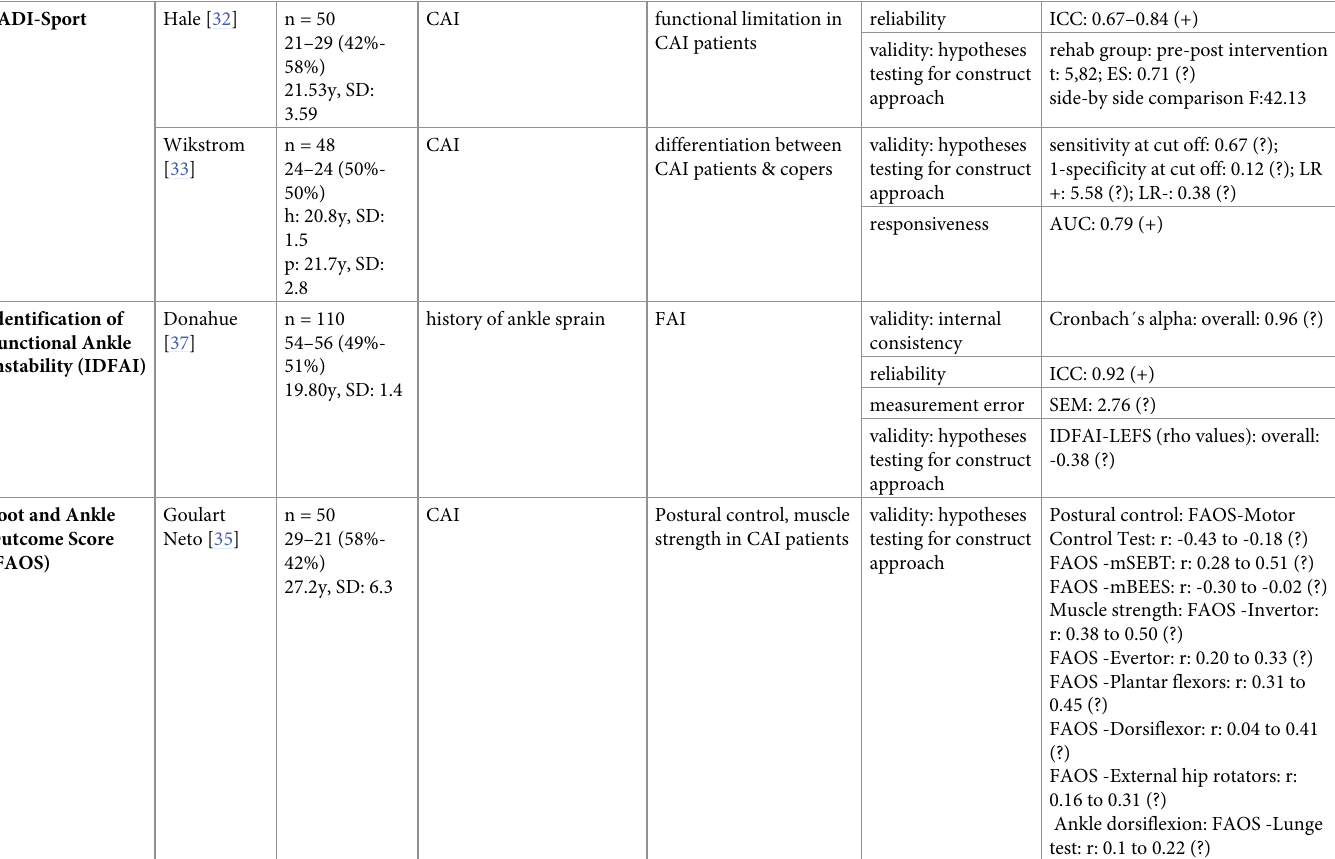
table adapted from COSMIN